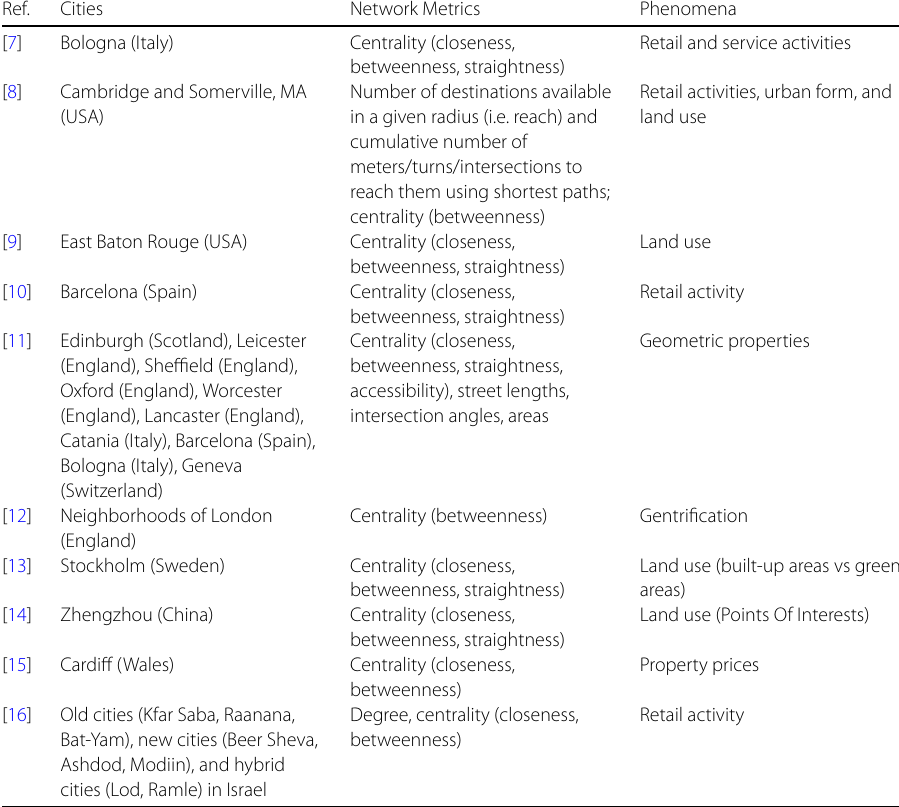
Table 1 Network science studies investigating various structures in road networks (sorted by year)